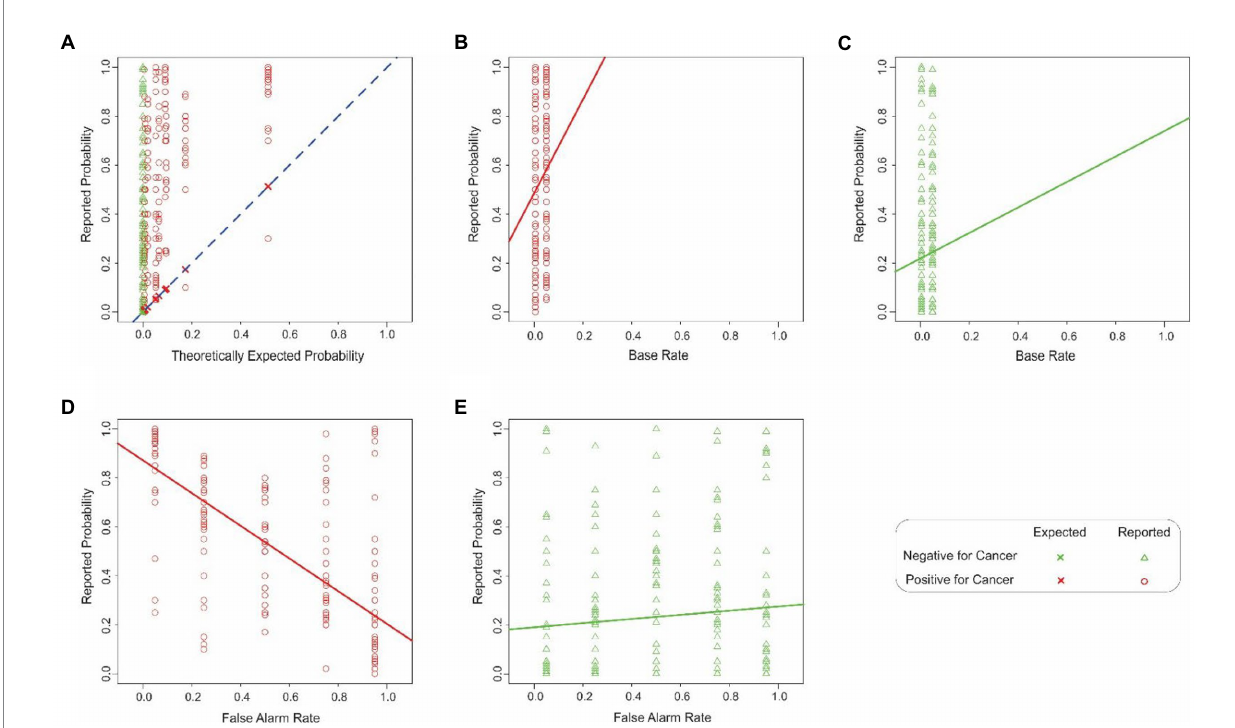
FIGURE 1 Estimation errors in Experiment 1. (A) Probability of cancer estimated by the subjects ( y-axis ) as a function of the corresponding theoretically expected probabilities ( x -axis). Each red circle or green triangle denotes a single trial in which the hypothetical CAD system decided that the mammogram in question was positive or negative for cancer, respectively (see legend at bottom right ). The ‘X’ symbols and the dashed diagonal denote hypothetical scenarios where the subjects’ estimated probability exactly matched the corresponding expected probability. The color of the plotting symbols ( red vs. green ) denote individual trials in which the CAD system determined that the given mammogram was positive or negative for cancer, respectively. The lines denote the best-fitting linear regression line in each case. (B,C) The interaction between the base rate and the binary decision of the system. The same plotting conventions as in panel A are used, except that in this panel, the estimated probability ( y-axis ) is plotted against the base rate ( x-axis ). For visual clarity, the data corresponding to the two decisions of the CAD system (mammogram positive or negative for cancer) are shown separately in panel d and e, respectively. In either panel, the solid and dashed lines denote best-fitting regression line. Panels (D,E) similarly show the interaction between the false alarm rate and the binary decision of the system, the estimated probability ( y-axis ) is plotted as a function of whether the CAD system decided that the mammogram was positive or negative for cancer (panel D or E ), respectively. See text for